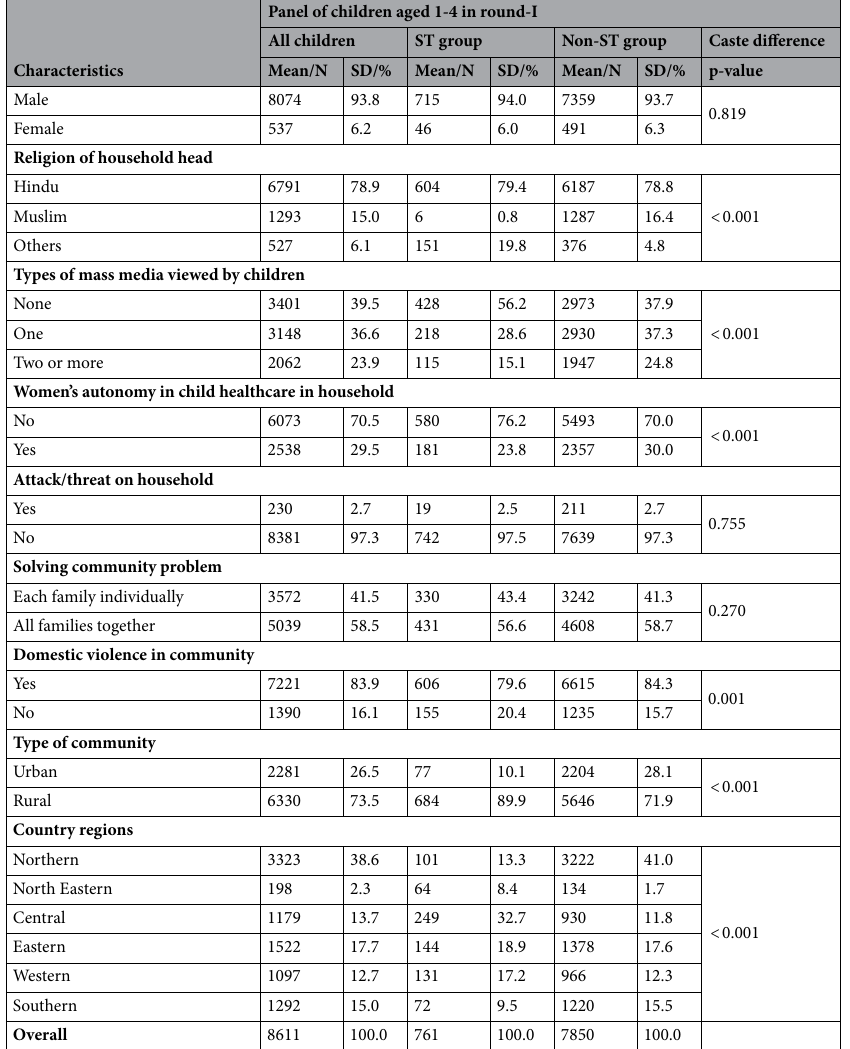
Table 1. Socio-demographic, health-related, household and community characteristics profile of the panel of children aged 1–4 years during IHDS round-I. (a) N sample size, SD standard deviation, %: column percentage; (b) difference in educational wellbeing score by caste group was tested using T-test while the caste difference of explanatory variables was tested using the chi-square test for